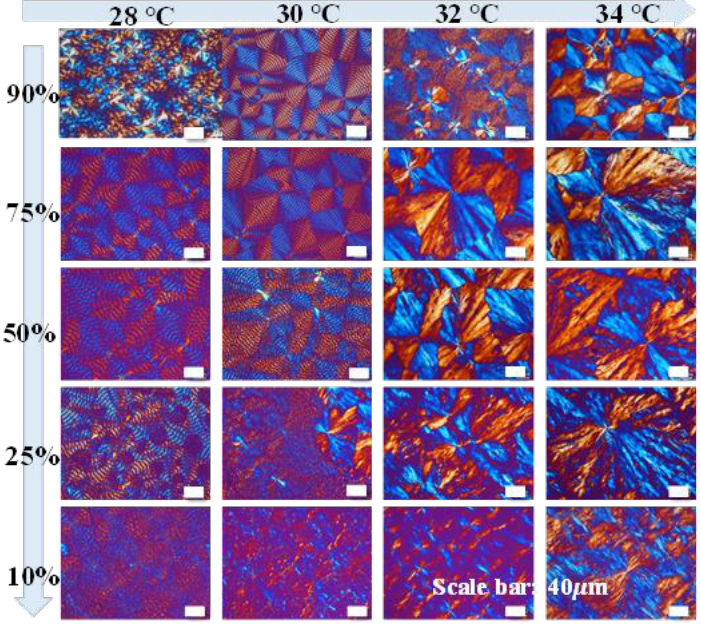
Figure 1. POM graphs of PBA/PEO blend of various compositions (PEO = 10–90 wt.%, top to bottom rows) crystallized at different T c (28 – 34 °C, Left to Right columns) by quenching from T max = 180 °C. Apparently, there is a transition zone from regular ring-banded patterns to highly dendritic ones, and this transition zone is exactly at the "corrupted ring band